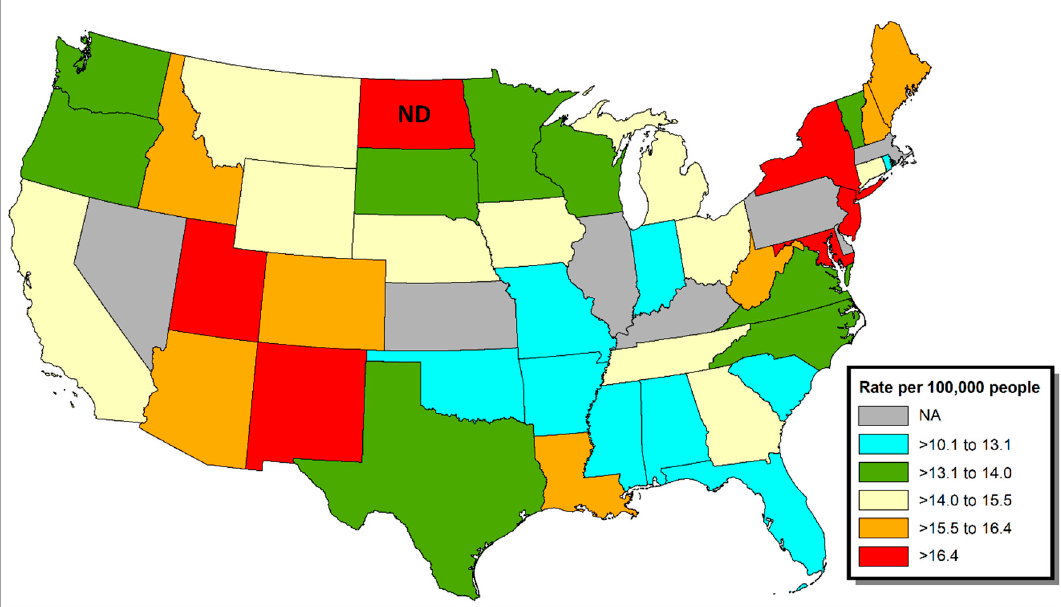
Figure 1. Thyroid cancer incidence in the continental U.S., by state, 2011–2015, for White non-Hispanics. Data are redrawn from State Cancer Profiles [10].